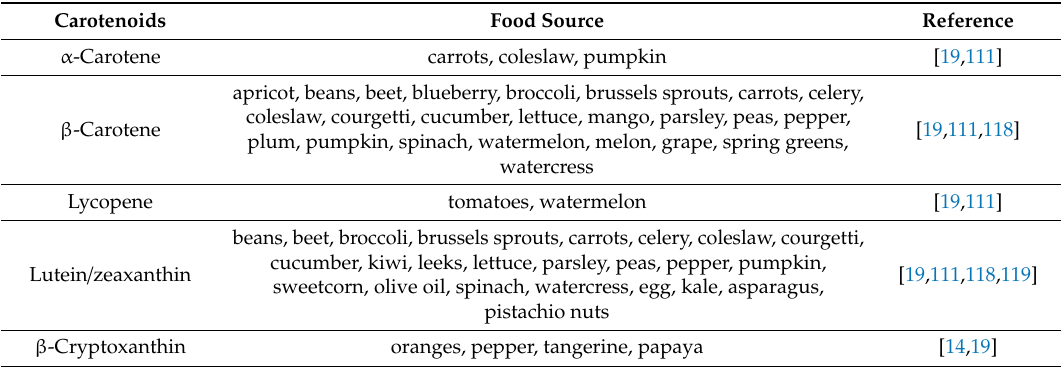
Table 1. Major representatives of carotenoids in